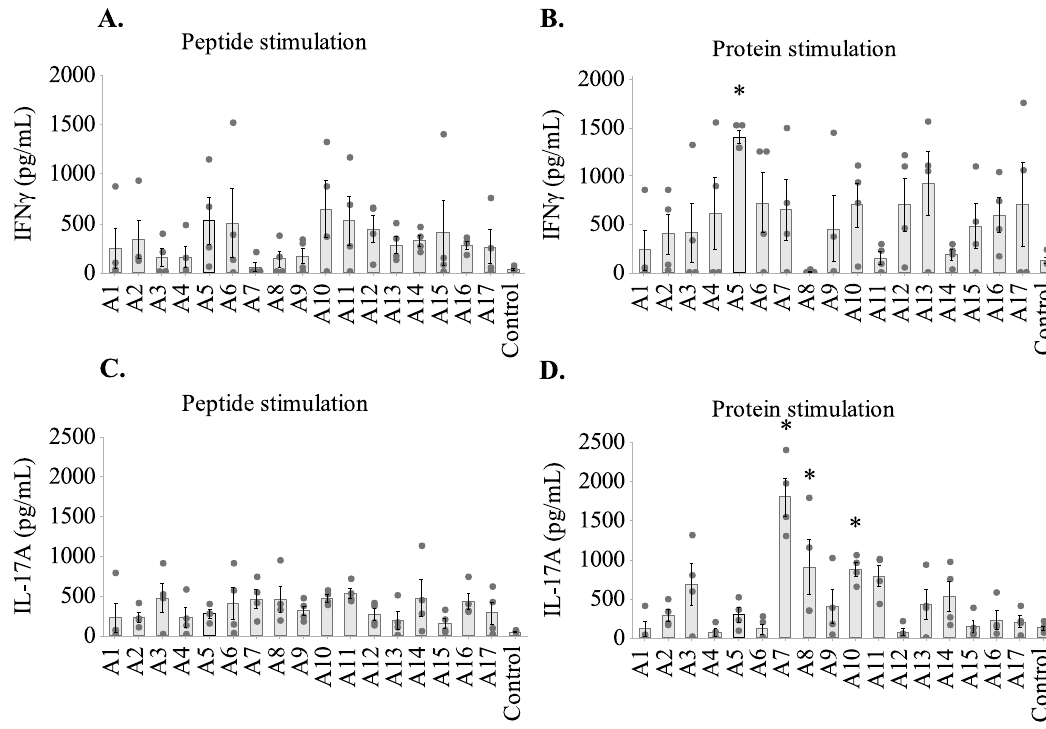
Figure 3. IFNγ and IL-17A levels in stimulated mouse splenocyte culture in vitro. IFNγ levels in the supernatants of ( A ) peptide-stimulated and ( B ) protein-stimulated splenocyte cultures. IL-17A concentration in supernatants of ( C ) peptide-stimulated and ( D ) protein-stimulated splenocyte cultures. Black dots represent individual data points of the IFNγ and IL-17A levels of individual mice. Bars represent the geometric mean (± SE) of culture supernatant from four mice vaccinated with each peptide. Significance differences to control (adjuvant only) group are shown as * P < residues 17–27 (L 1 ) and 107–121 (L 8 ) connecting β 1 –β 2 and β 8 –β 9 respectively. Peptides that generated stronger B- and T-cell responses are highlighted on the AdLP-D1 structure (Fig. 4B) and we observed that peptides such as A7 and A10 form tightly associating β-sheets within the macrostructure. Peptide A10 possesses a number of bulky solvent exposed side chain residues including Arg100, Tyr 99 and Tyr105 and an exceptional instability index value (− 9.59, Table 1). Amino acid sequence alignment of the four Big_1 domain of Mru_1499 using the MUSCLE alignment tool 30 revealed that the N-terminus Big_1 domain was most similar to other Big_1 domains of Mru_1499, with 58.7% amino acid identity to the second Big_1 at residues 195–283, 51.5% to the third Big_1 domain at residues 286–390, and 55.1% to the fourth Big_1 domain at residues 577–665 (Fig. 4C). Regions similar to overlapping peptides A10 and A11, which induced B- and T-cell responses in mice, were found in all 4 Big_1 domains (Fig. 4C) of AdLP. B‑cell epitope prediction. We predicted linear B-cell epitopes using the BcePred 31 1.0 server, ABCpred 18 , SVMtrip 20 and BepiPred 32 . The results are displayed in Fig. 5A as color intensity depicting the prediction of strong (royal blue), intermediate (sky blue), and low binding (light blue) affinities of B-cell epitopes. Screening of B-cell epitopes of AdLP-D1 by these prediction programmes revealed over- and under-prediction of B-cell epitopes along the whole length of the protein. Four peptides, A4, A7, A10 and A11 were mapped as B-cell epitopes of AdLP-D1. Of these peptides, A4 and A7 were predicted as B-cell epitopes by BepiPred and A11 was predicted by BcePred and SVMtrip. Peptide A10 was not predicted as a B-cell epitope by any of the four pro- grammes we used in this study, yet it stimulated a strong IgG1 and IgG2a antibody response. T cell epitope prediction. Three algorithms, IEDB 15 , SYFPEITHI 14 and Rankpep 13 , were used to predict T-cell epitopes in AdLP-D1. Peptides sequences were submitted to these servers for MHC class 1 alleles H2-Kd, H2-Dd and H2-Ld, and for MHC class II alleles H2-IED and H2-IAd binding predictions. Of the three, the IEDB Analysis Resource database using the NetMHCpan prediction method generated quantitative prediction of the affinity of the peptides to both MHC class I and II interaction that were partially in agreement to our experimental data of T-cell epitopes (Fig. 5B). Although predicted MHC I and II restricted epitopes by IEDB were evenly distributed throughout the protein sequence (Fig. 5B), three of the five peptides (A5, A7, A8, A10 and A13) mapped as T-cell epitopes were predicted as T-cell epitopes with strong affinity by two or more pro- grammes. For instance, Rankpep 13 predicted A5 for MHC class I allele H2-Ld and MHC class II allele I-Ed, while IEDB predicted A5 for MHC class 1 allele H2-Kd with intermediate affinity and MHC class II allele I-Ad with